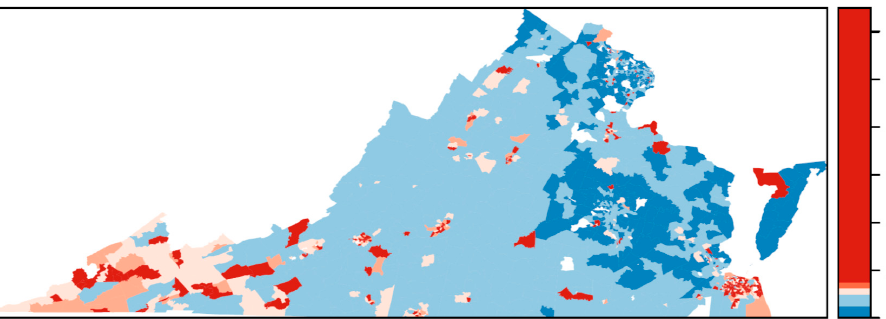
Figure 1. Estimated relative risk for tobacco retail outlets across Virginia census tracts, 2018.